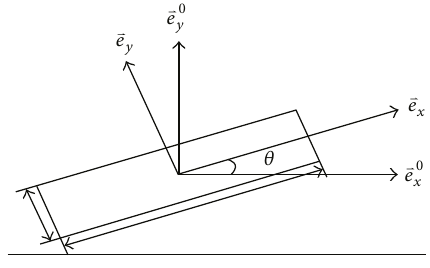
Figure 2: The section of the rotating cantilever